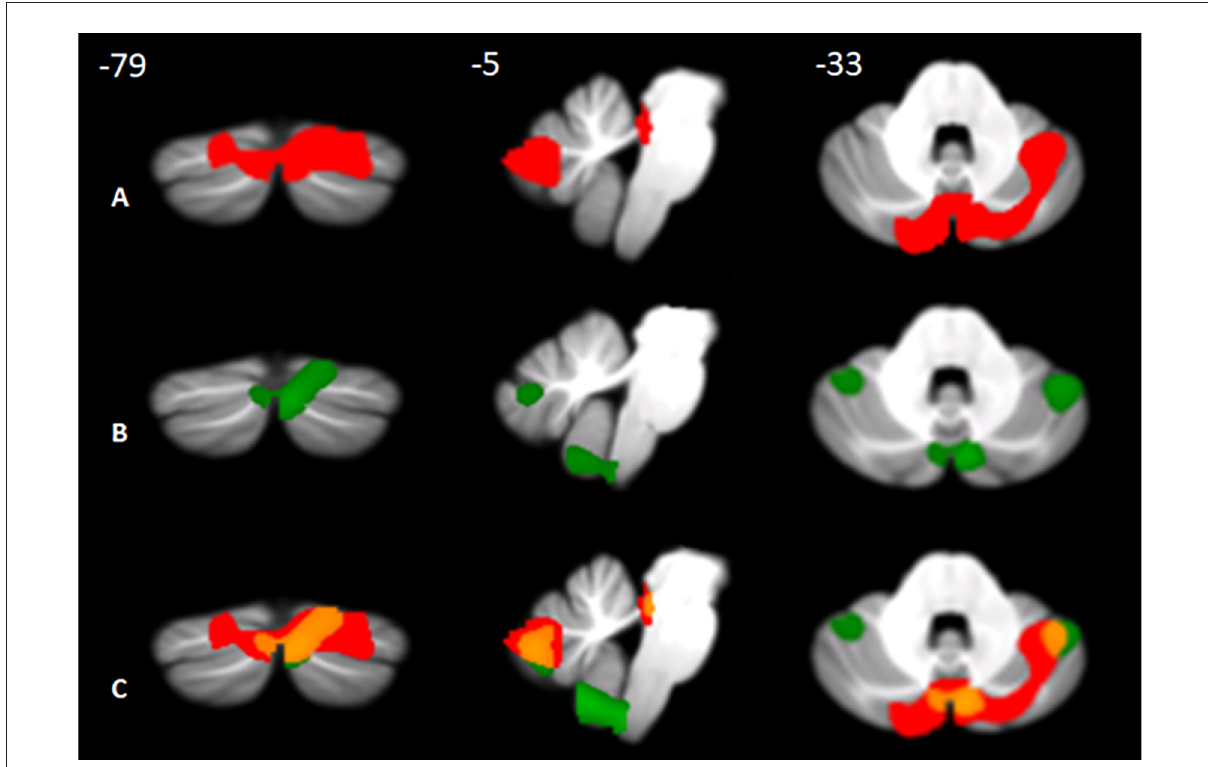
FIGURE2 Between-group voxel-based comparison of cerebellar GM density. Cerebellar regions showing patterns of significantly reduced GM in BD1 (A) and BD2 (B) compared to MRI-HS are reported and superimposed on the Spatially Unbiased Infratentorial Template (SUIT; Diedrichsen et al., 2009) in coronal (y), sagittal (x), and axial (z) slices. The results are significant at p-values < 0.05 after FWE cluster-level correction. Images are shown in neurological convention. Regions of overlapping cerebellar GM loss (C) between BD1 (in red) and BD2 (in green) are reported in orange.